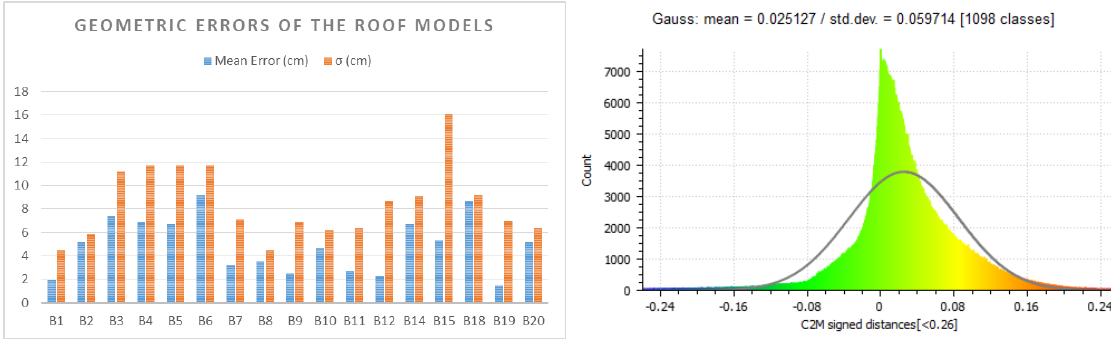
Figure 9. Geometric mean deviations between each generated roof 3D model and the original point cloud and their respective standard deviation values ( left ) and a histogram fitted to a Gauss curve representing the global values of the same error ( right